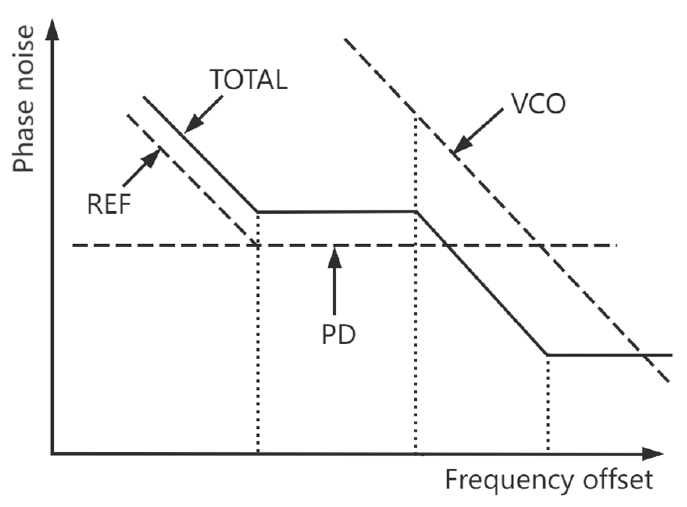
Figure 6. Single-loop PLL phase noise model.